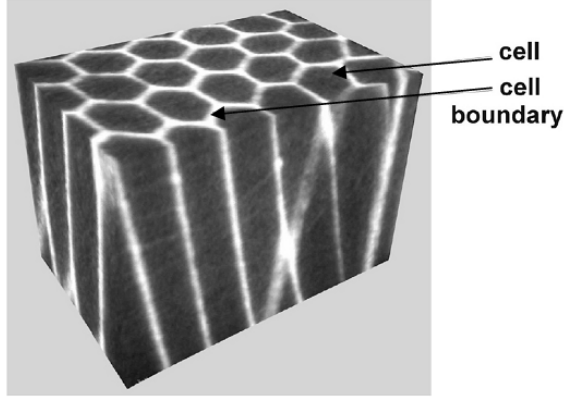
Figure 1: Scheme of a functionally designed cellular microstructure (adapted from